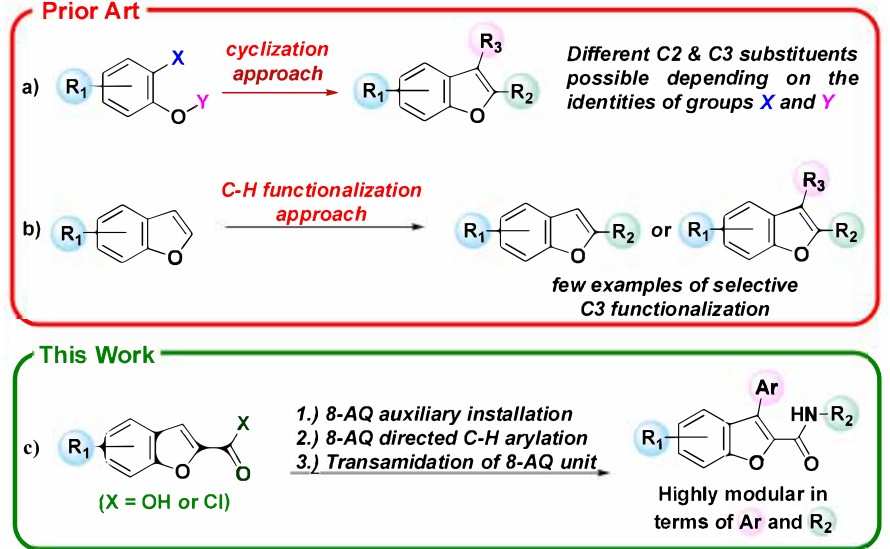
Scheme 1. Di ff erent synthetic strategies to access highly functionalized benzofurans. ( a , b ) General representations of prior cyclization- and C–H functionalization-based approaches. ( c ) The herein described approach towards C3-substituted benzofuran-2-carboxamide derivatives enabled by a combination of 8-AQ directed C–H arylation and transamidation